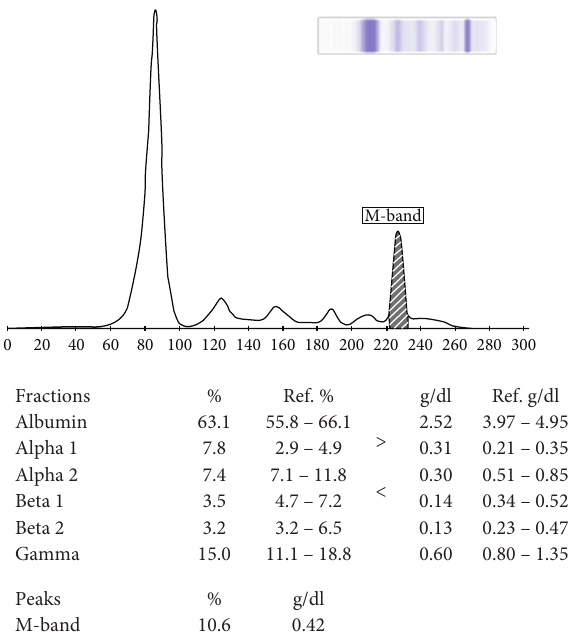
Figure 2: Serum protein electrophoresis showing an M protein of Table 1: Selected lab investigations during his hospital stay.